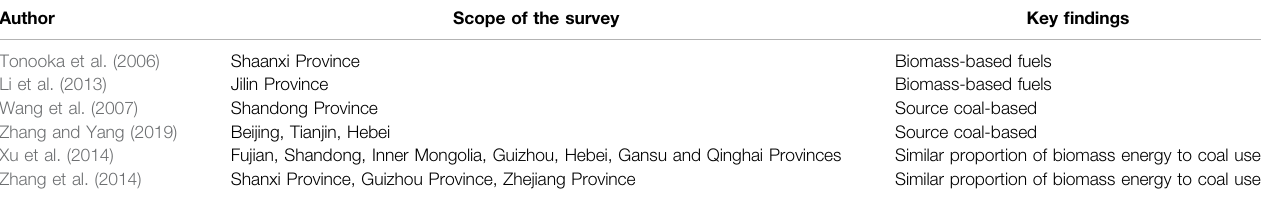
TABLE 1 | Key fi ndings on the structural characteristics of household energy consumption.